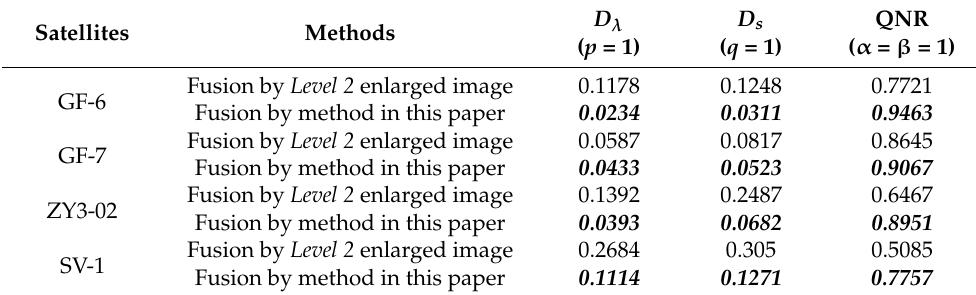
Table 3. Global distortion/quality index integrated with fused